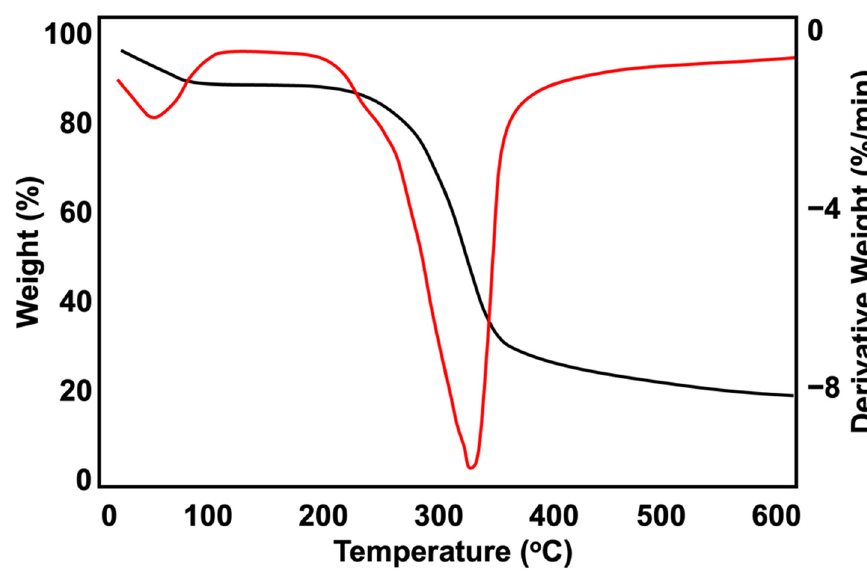
Figure 4. TGA (black) and DTG (red) profiles of KP.